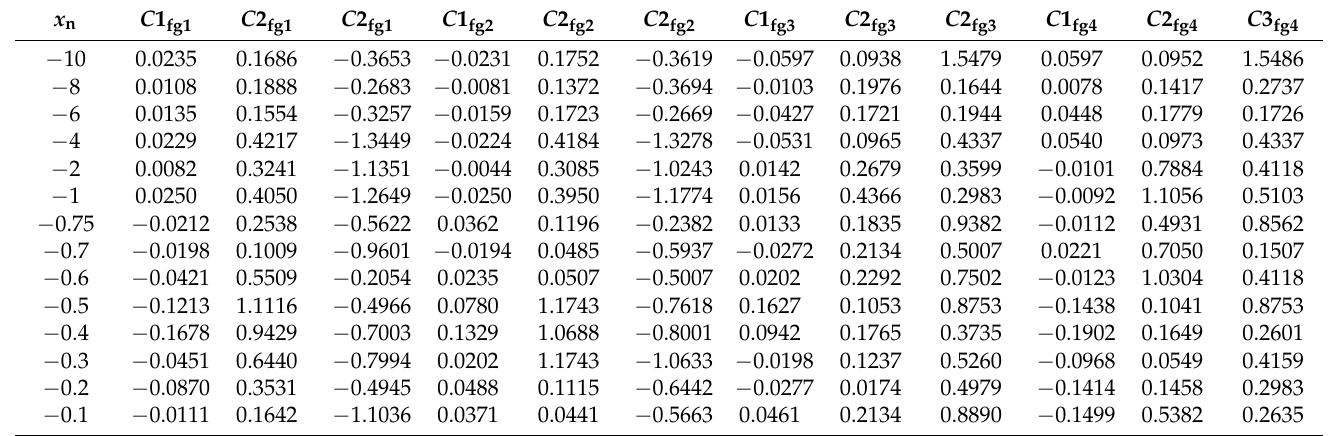
Table A3. The fitting parameters in Gaussian-type functions, f G_ i , ( x n < 0).